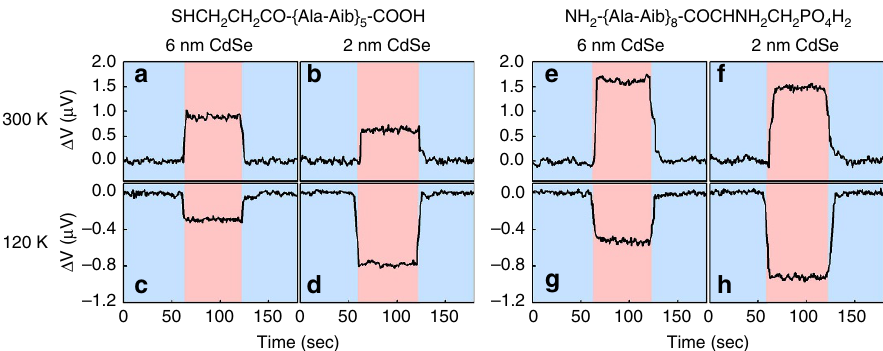
Figure 5 | Hall voltage measurements at different temperatures and for different sizes of nanoparticles. All measurements were performed at 300K and at 120K for devices of the type shown in Fig. 4, coated with 6 and 2nm diameter CdSe nanoparticles that are attached to the GaN surface via NH 2 -{Ala-Aib} 8 -COCHNH 2 CH 2 PO 4 H 2 or SHCH 2 CH 2 CO-{Ala-Aib} 5 -COOH molecules, at a current of 10 m A. The devices were illuminated with a 2.3mW, 514nm laser. Three sets of devices were measured and the variation in the signal among them is about 10%. The signal observed corresponds to effective magnetic fields of 20, 16, -5, -18, 73, 36, -8 and -22G for panels a , b , c , d , e , f , g and h , respectively. All plots are presented after subtracting a background signal, measured for the same devices but covered with the non-chiral 11-mercaptoundecylphosphoric acid (see Supplementary Fig. 8). Pink and light-blue areas correspond to ‘light on’ and ‘light off’ regimes, respectively. NATURE COMMUNICATIONS|7:10744|DOI: